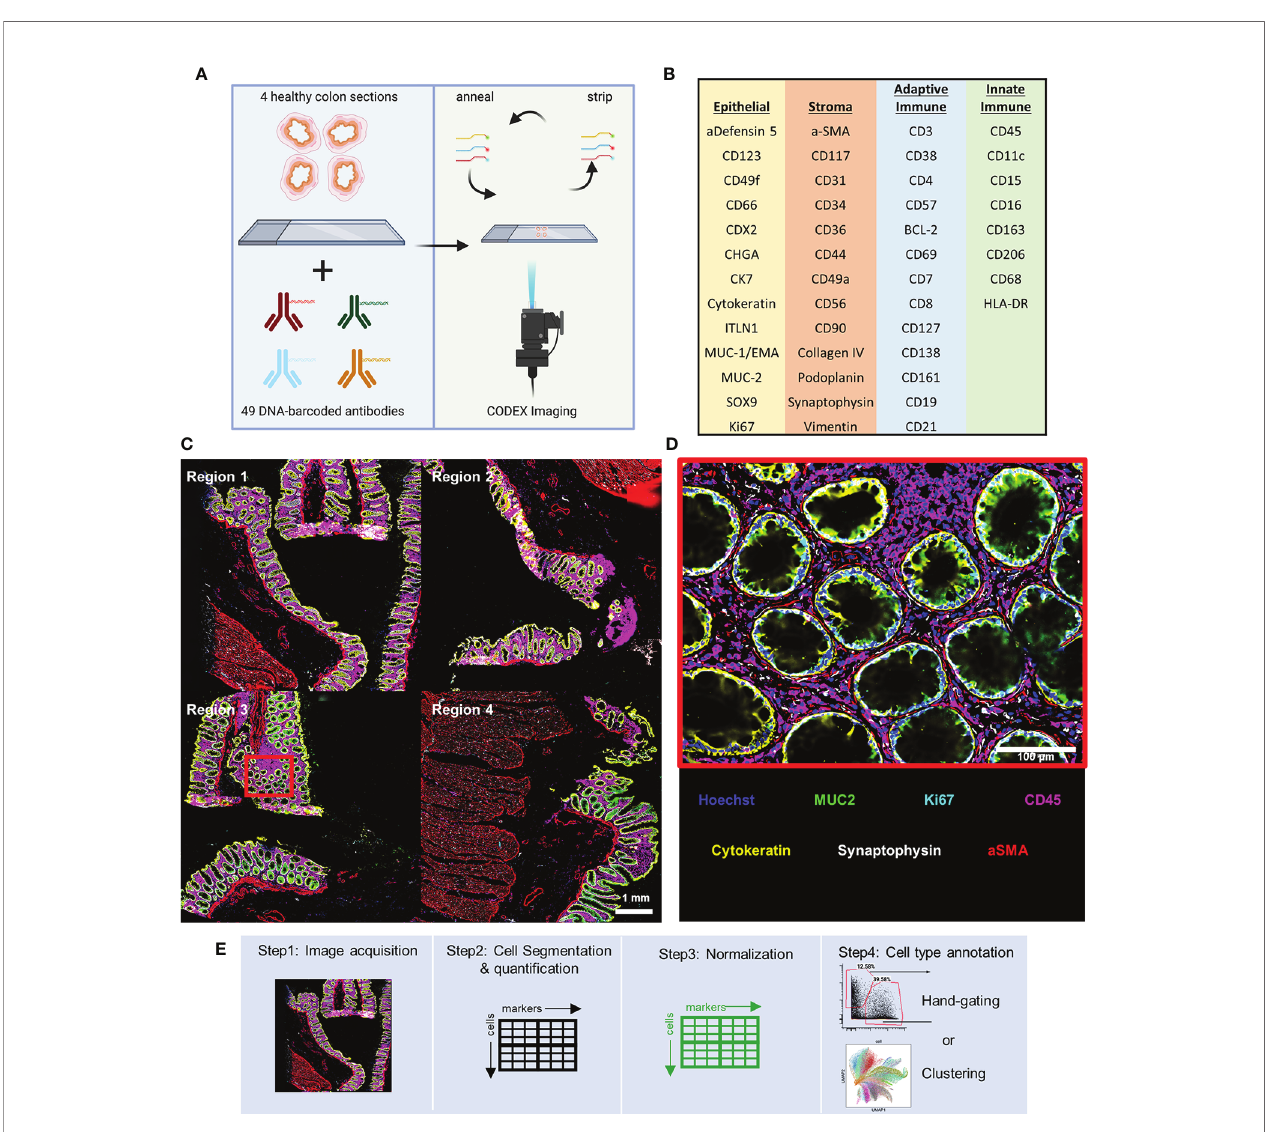
FIGURE 1 | CODEX multiplexed imaging of the human colon. (A) Schematic of the CODEX protocol for imaging of sections of ascending, transverse, descending, and sigmoid colon. (B) The 47 CODEX oligonucleotide-barcoded antibodies used discriminate several major epithelial subtypes of the colon, stromal cell types, and both adaptive and innate immune cell types. (C) Image with six representative markers highlighted with data for CD45 (magenta), MUC2 (green), Ki67 (cyan), Synaptophysin (gray), Cytokeratin (yellow), and aSMA (red) (scale bar = 1 mm). (D) Magni fi ed view of the region indicated with the cyan box in panel (C) (scale bar = 100 m m). (E) The work fl ow for single-cell multiplexed imaging preprocessing used in this